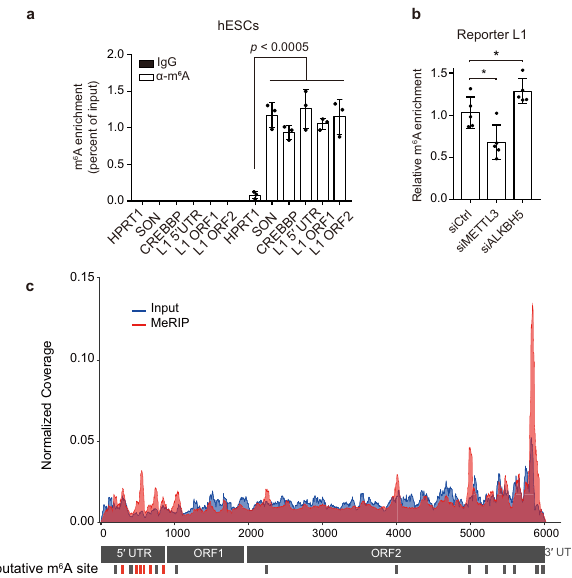
Fig. 2 L1 RNA is modi fi ed by m 6 A. a MeRIP-qPCR analysis of mRNA from H9 hESCs. Eluates from IgG immunoprecipitation served as negative control. Eluted RNA was quanti fi ed to determine the percentage of input. ( n = 3 independent samples, mean ± s.e.m., one-way ANOVA and Dunnett ’ s multiple comparisons test). b MeRIP-qPCR analysis of pL1Hs- transfected HeLa cells with m 6 A machinery knockdown. Eluted RNAs were quanti fi ed using primers speci fi c for reporter L1. The enrichment of RNA was normalized to that of the control. ( n = 5 independent samples, mean ± s.e.m., unpaired two-tailed t -test, * p < 0.05). c Map of m 6 A modi fi cation sites in full-length L1Hs from previously reported MeRIP-seq data for H1 hESCs (GSE52600). Read coverage was normalized to the total number of reads mapped to the L1Hs consensus sequence. The plot presents data from MeRIP-seq in red and input RNA-seq in blue. Bars (in red or black) indicate the m 6 A peaks identi fi ed by manual inspection in two replicates. m 6 A peaks in red correspond to peaks containing high score m 6 A- prediction sites. Source data are provided as a Source data fi